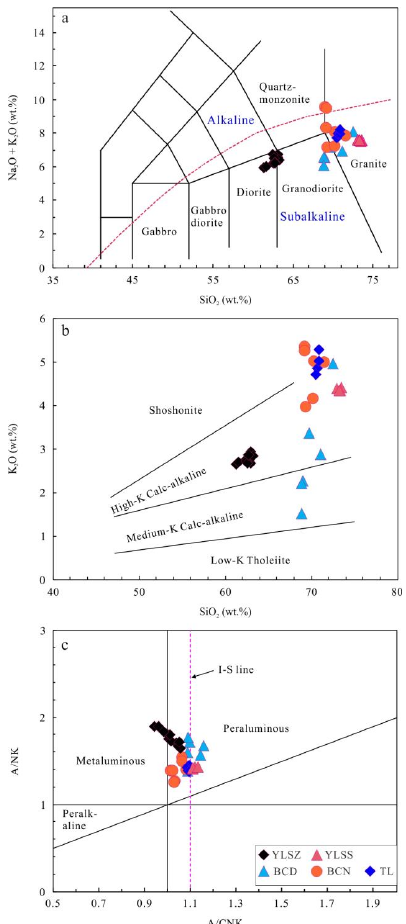
Figure 6. (Na 2 O+K 2 O) versus SiO 2 ( a ) [76]; K 2 O versus SiO 2 ( b ) [77]; and A/NK versus A/CNK ( c ) [78] diagrams for the Yilashan and Amdo granitoids in the Nagqu area.